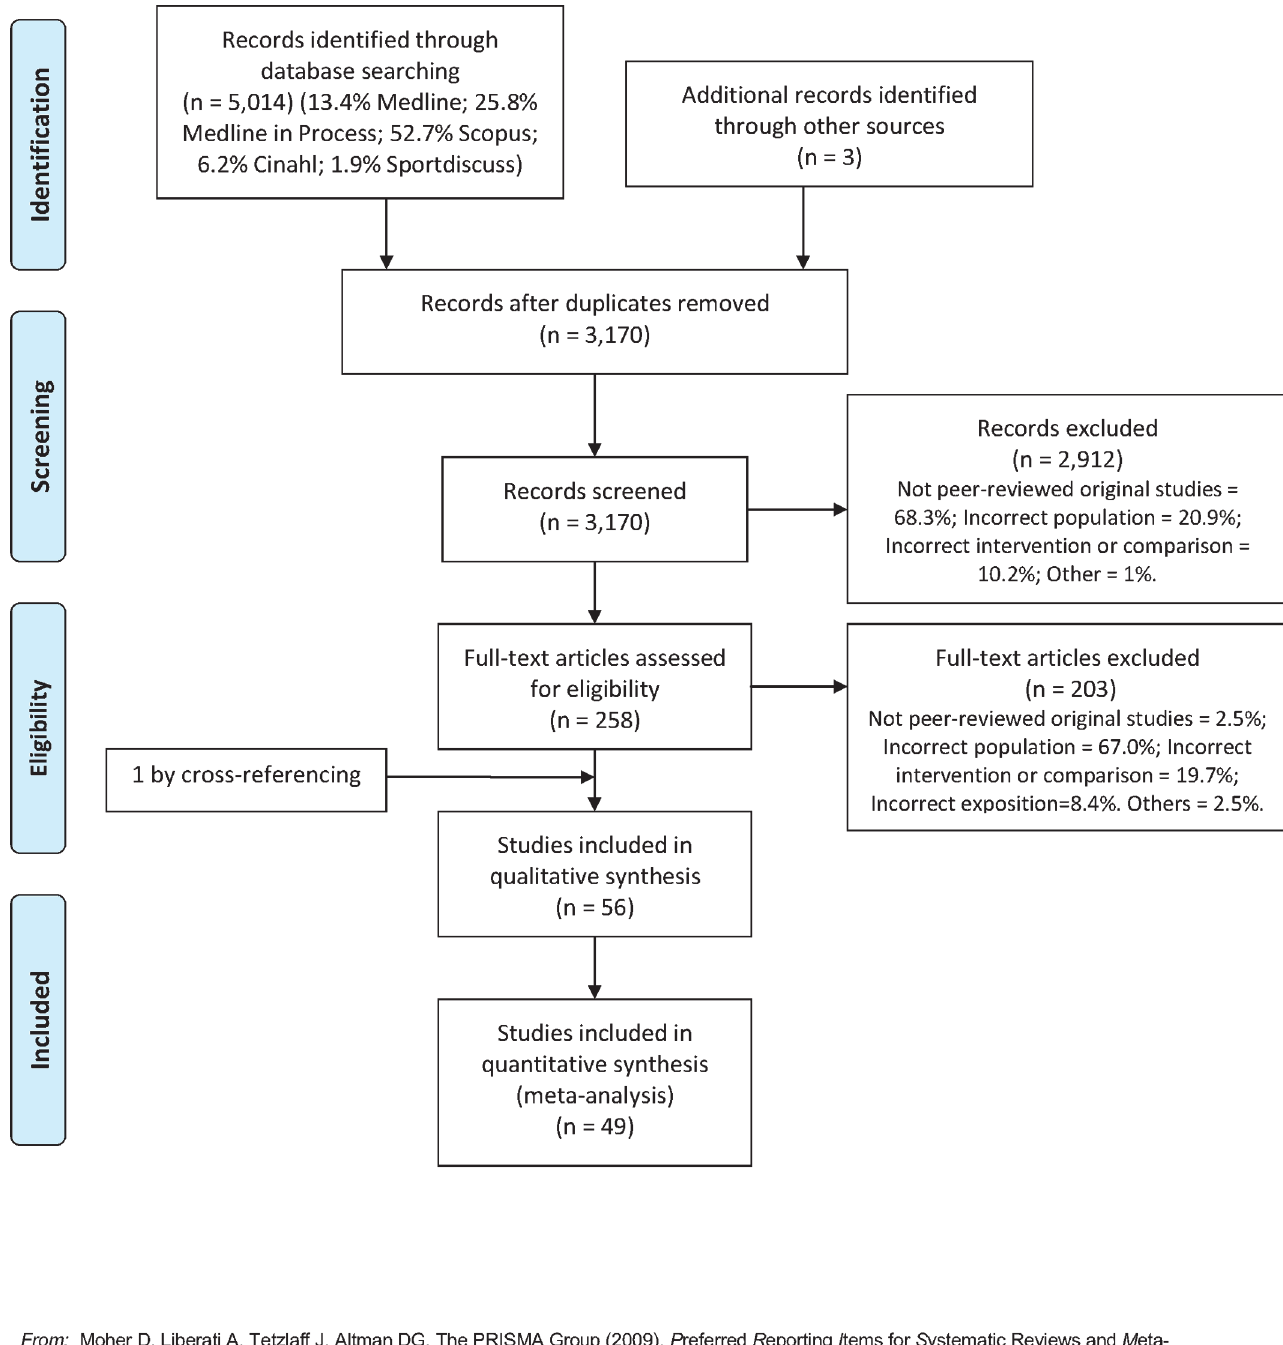
Fig 1. PRISMA 2009 Flow Diagram.